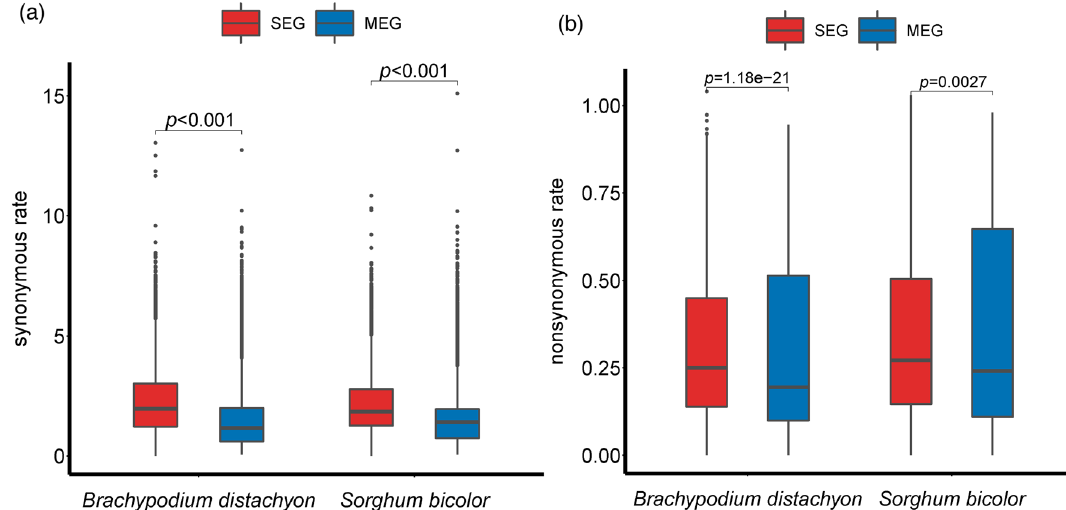
Fig. 5 Comparison of the synonymous ( a ) and non-synonymous substitution rates ( b ) between rice and Brachypodium distachyon , and Sorghum bicolor orthologous gene pairs of single-exon genes and multiple-exon genes in